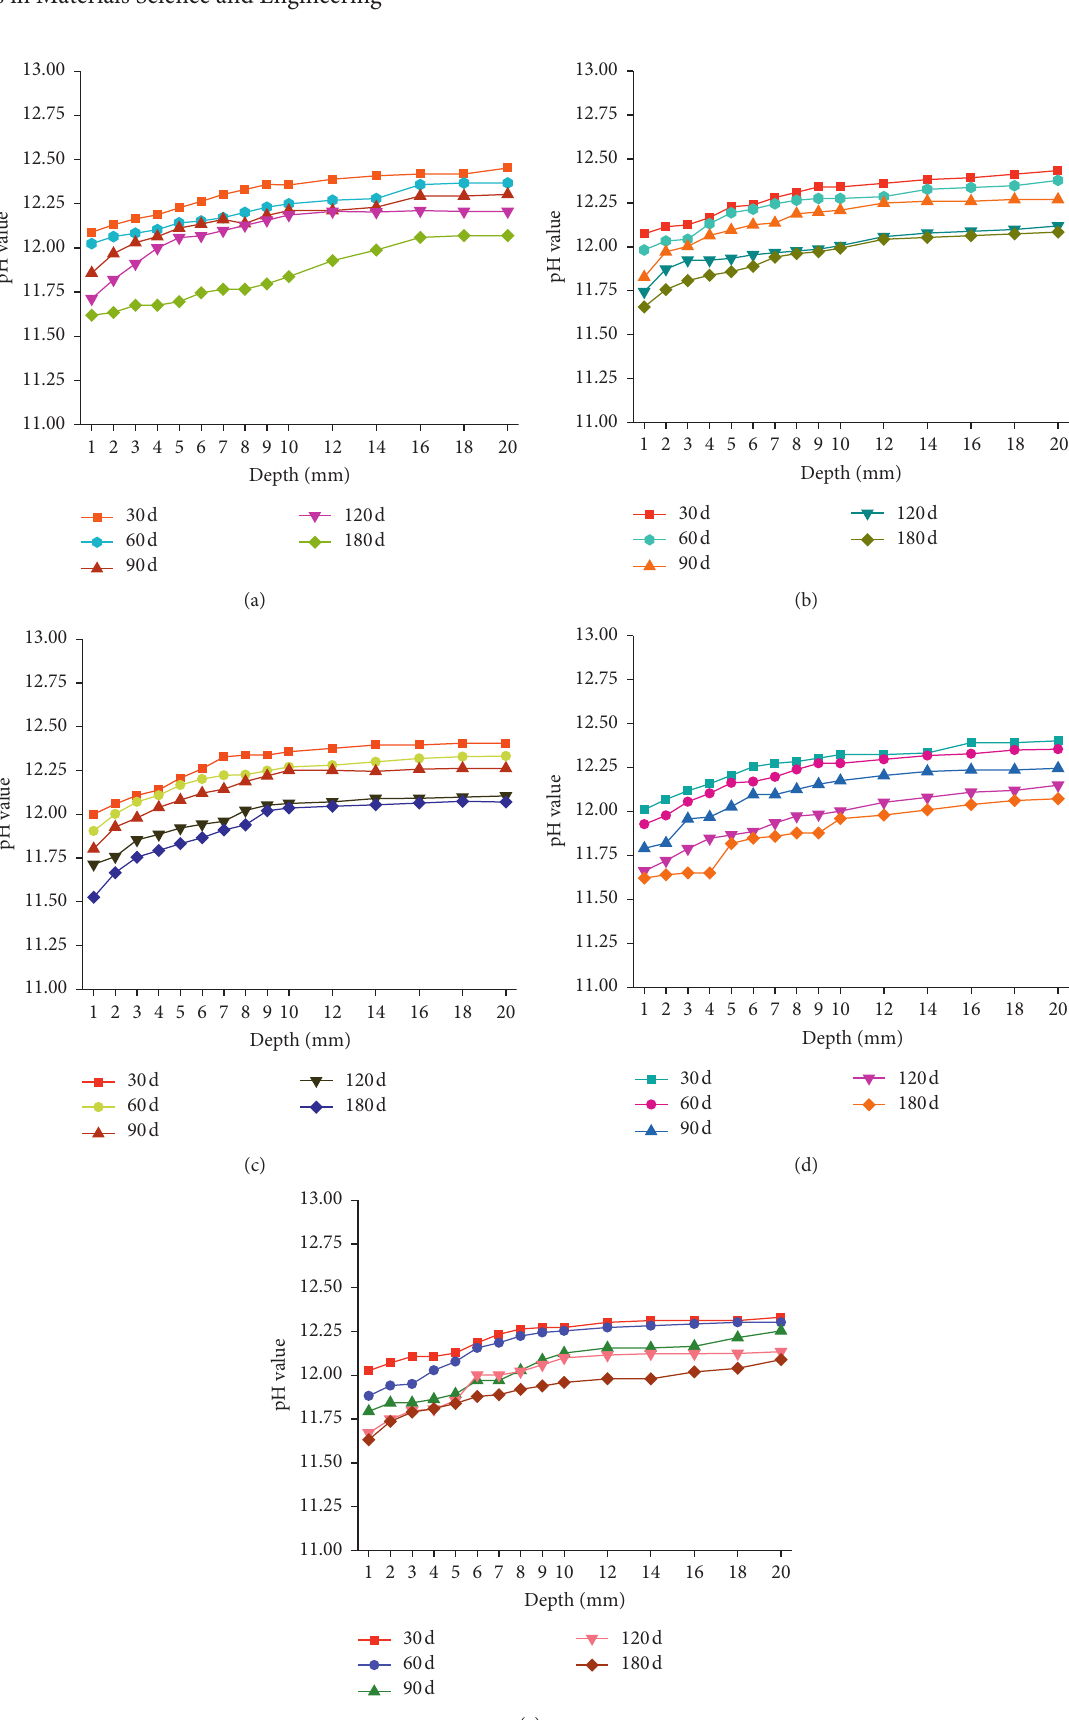
Figure 5: Pore solution pH of C40 concrete with different fiber type and content. (a) HC-40. (b) BC-40-0.1. (c) PC-40-0.1. (d) BPC-40-0.1. (e)